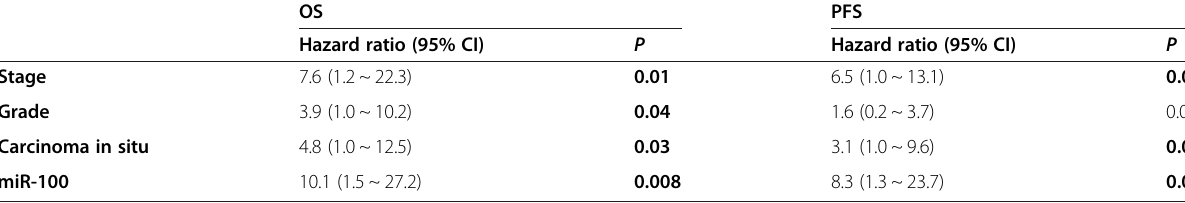
Table 4 Multivariate analyses with the Cox log-rank test of the effect on OS and PFS